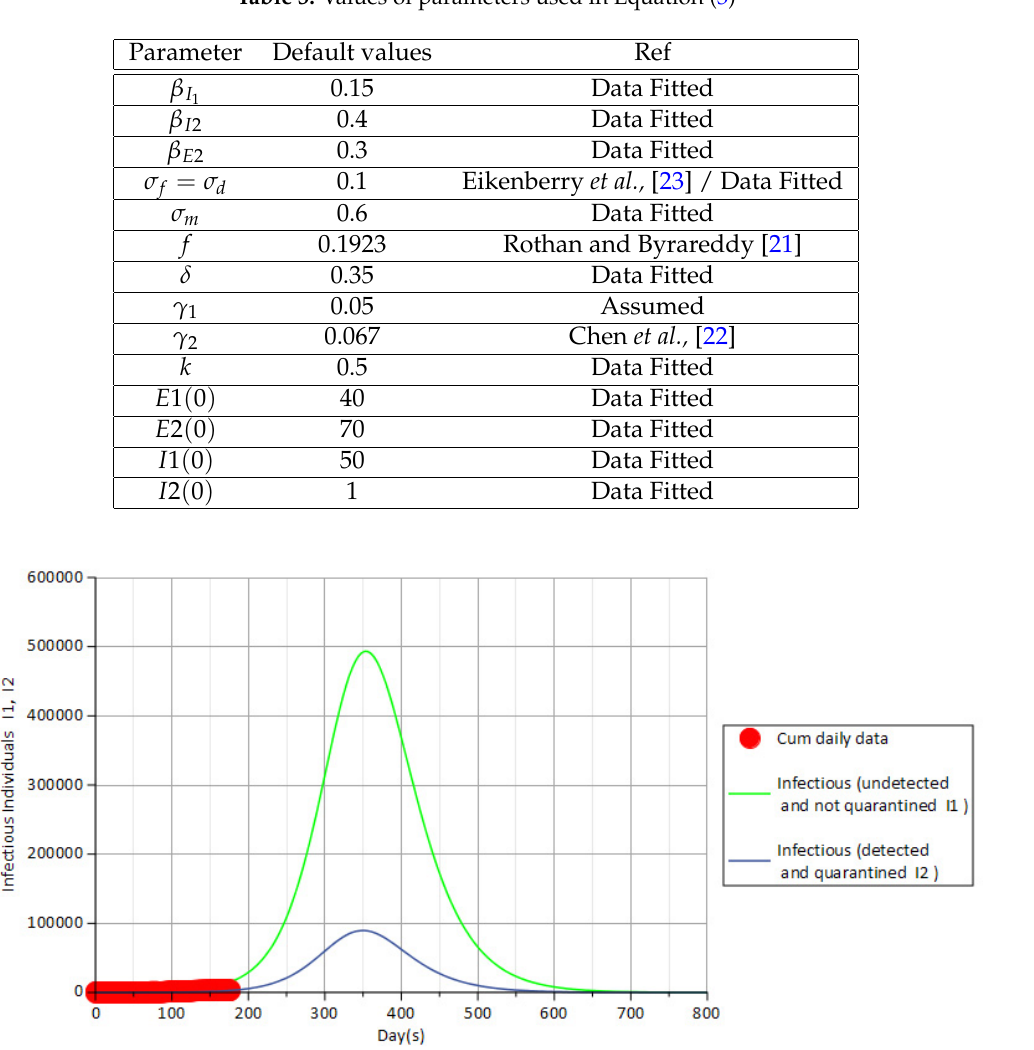
Table 3. Values of parameters used in Equation (3)